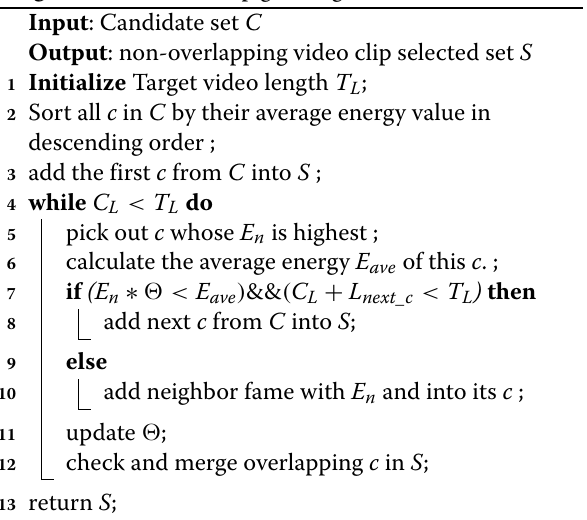
Algorithm 1: Video clip growing